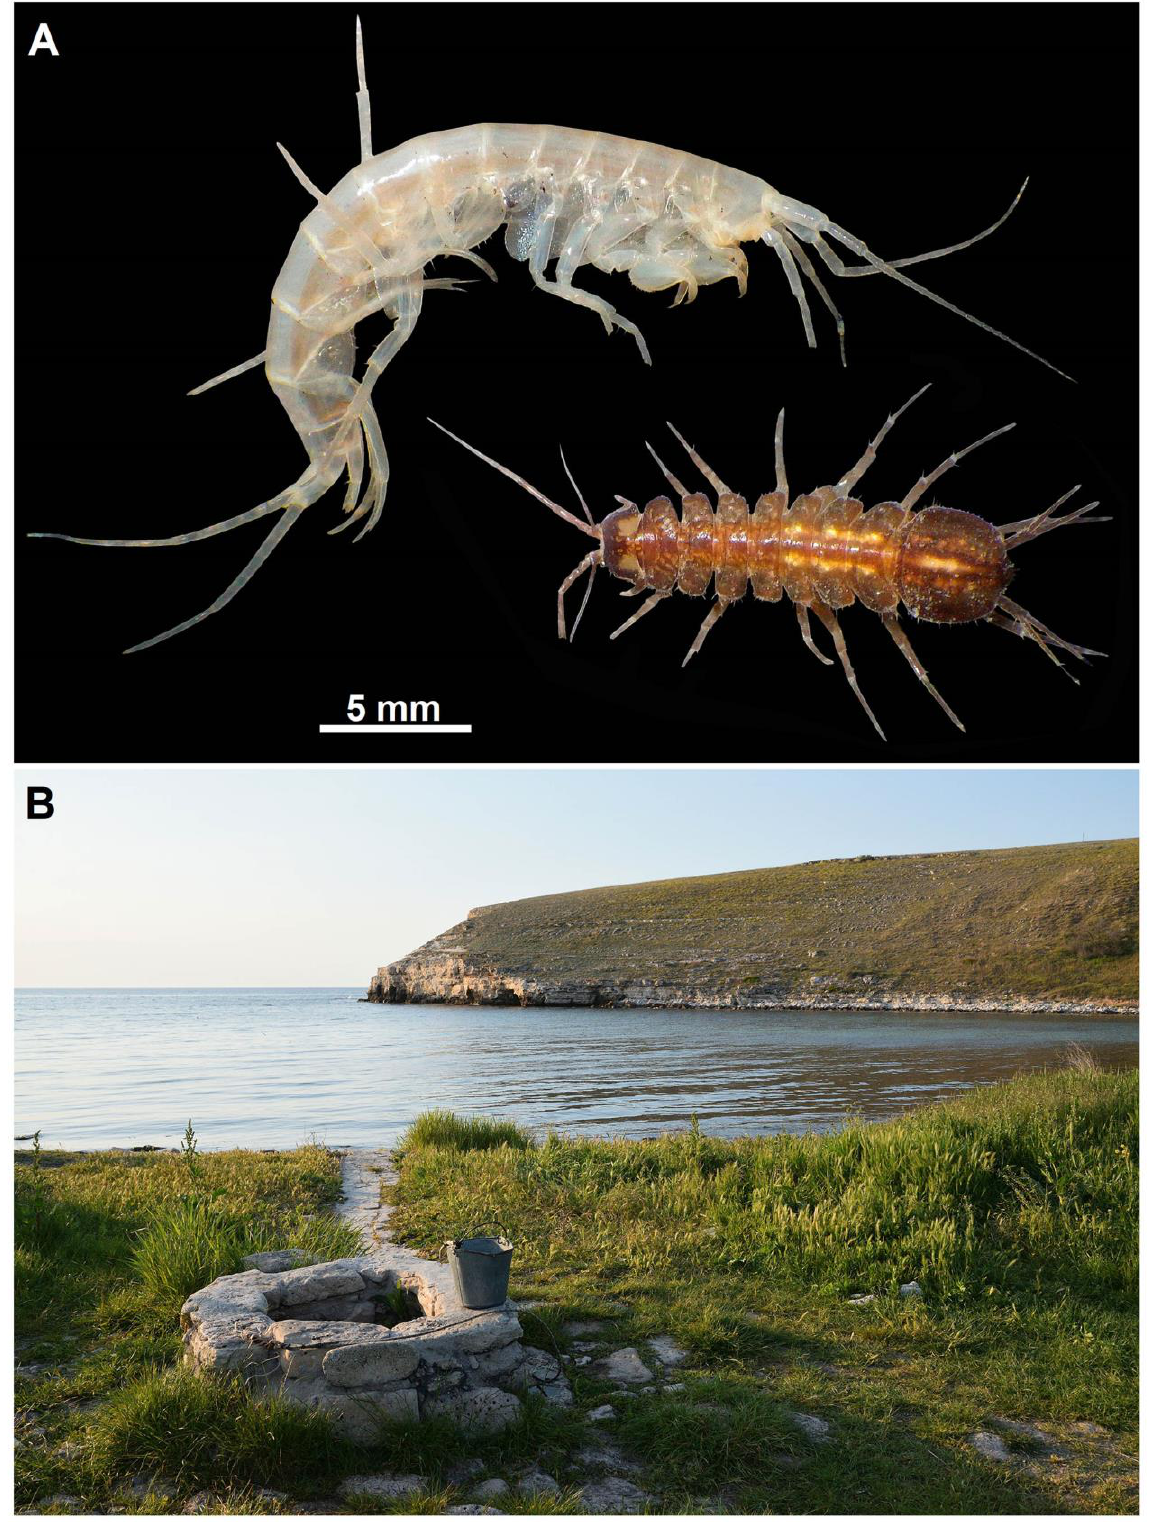
Figure 2. General view and live coloration of Niphargus tarkhankuticus sp. nov. and Asellus cf. aquaticus (Linnaeus, 1758) ( A ). The well in the Bolshoy Kastel Bay (type locality), Tarkhankut Upland, in the northwestern part of the Crimean Peninsula ( B